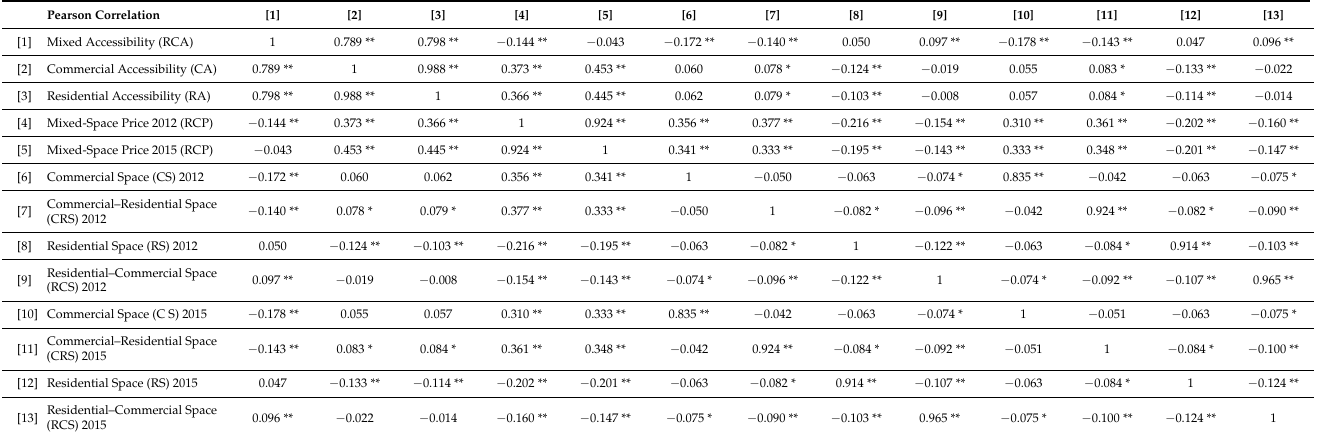
Table 3. Correlation